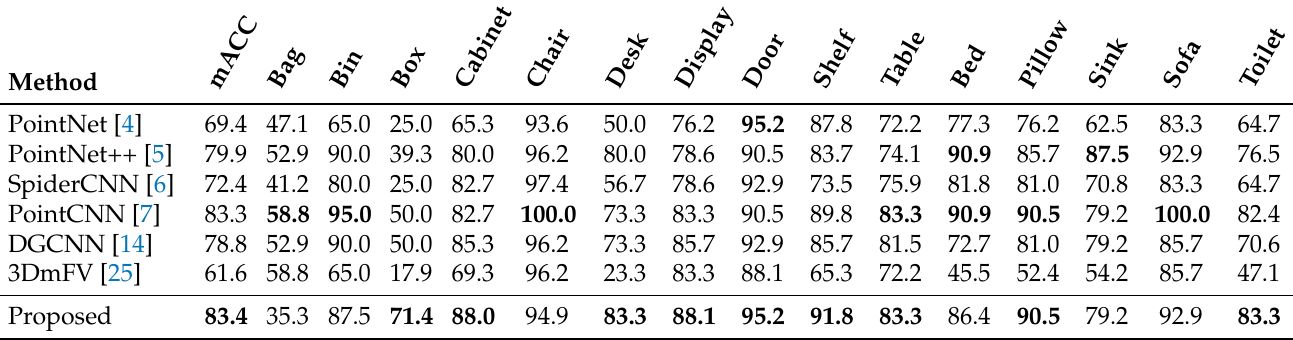
Proposed Table A3. Per-class accuracies (in %) for ScanobjectNN-Background. PSNet achieves the highest mACC accuracy. It also performs better than all of the compared methods for the categories of box, cabinet, desk, display, shelf, and toilet, etc.